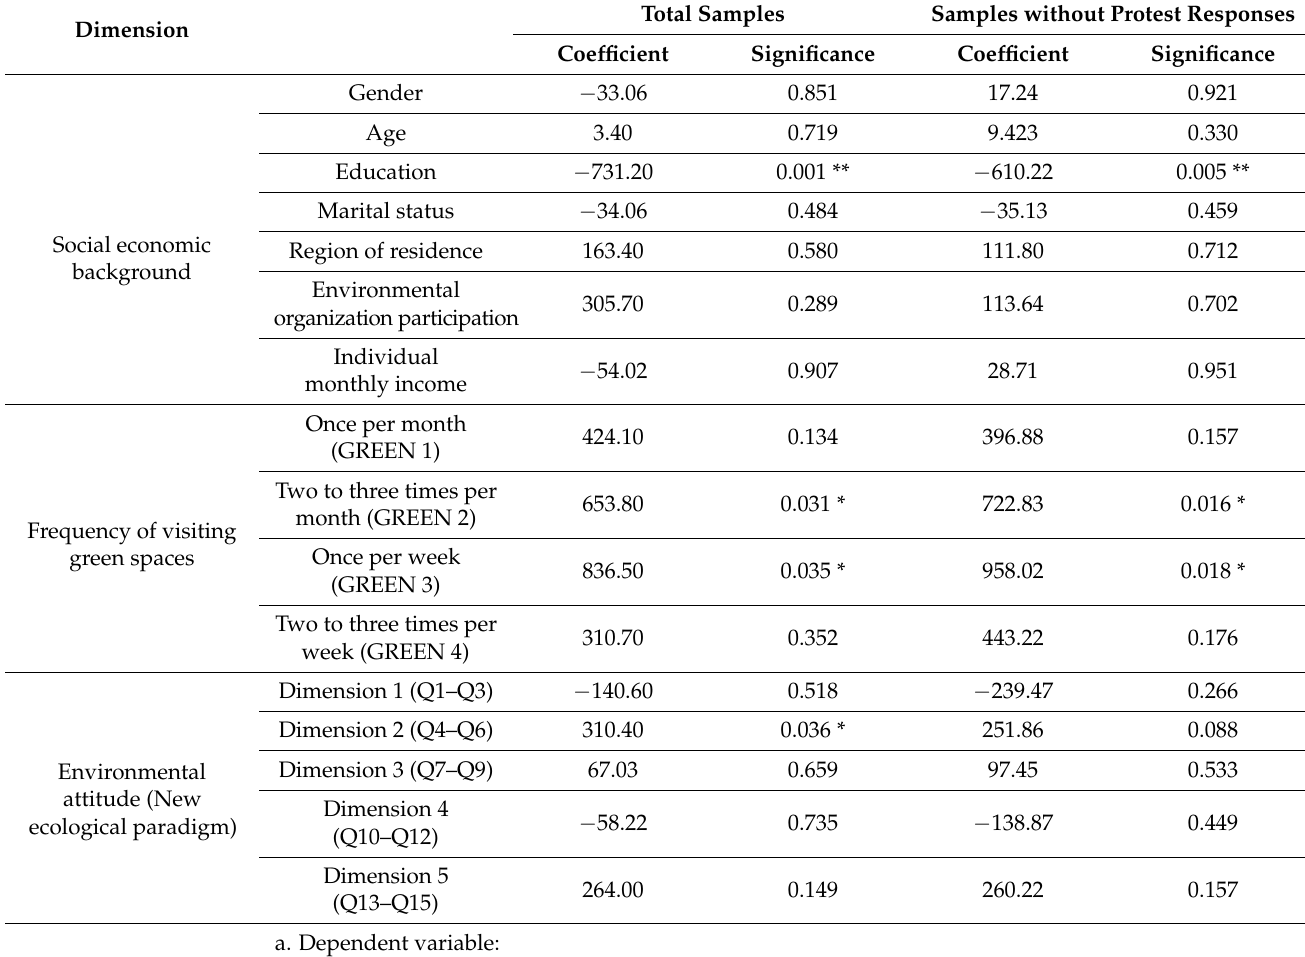
Table 6. Tobit regression analysis results of ecological value regarding visitors to the Sinhua Forest Park.